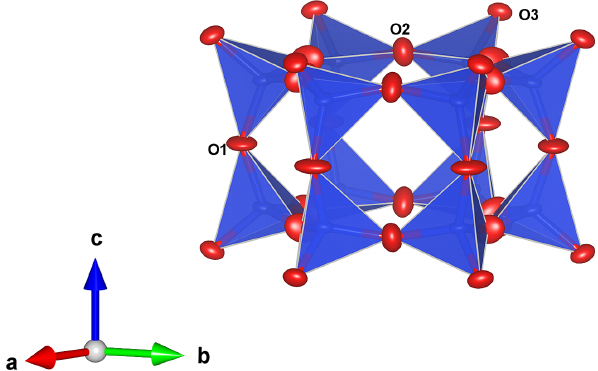
Figure 6. The double ring of T (1) tetrahedra, obtained with VESTA 3.0 (Momma and Izumi, 2011).